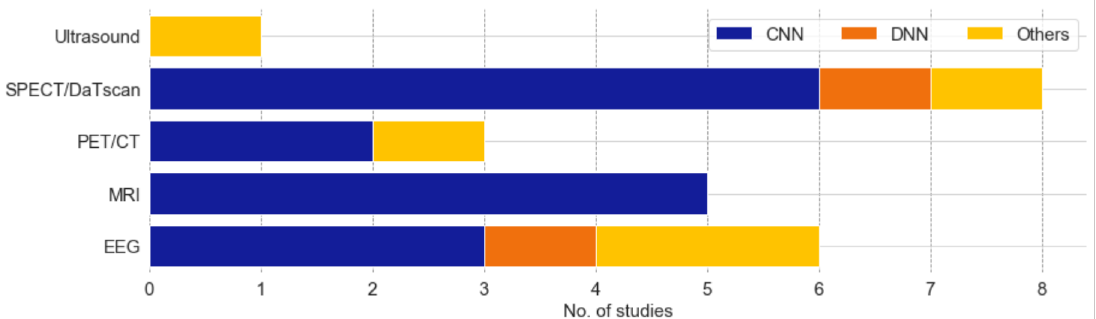
Figure 5. Stacked bar plot of the number of deep learning models proposed for each modality of brain analysis.